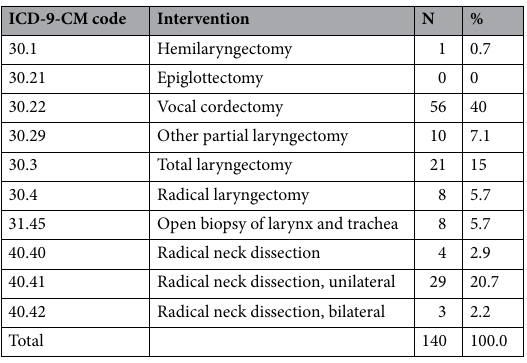
Table 2. Distribution of surgical